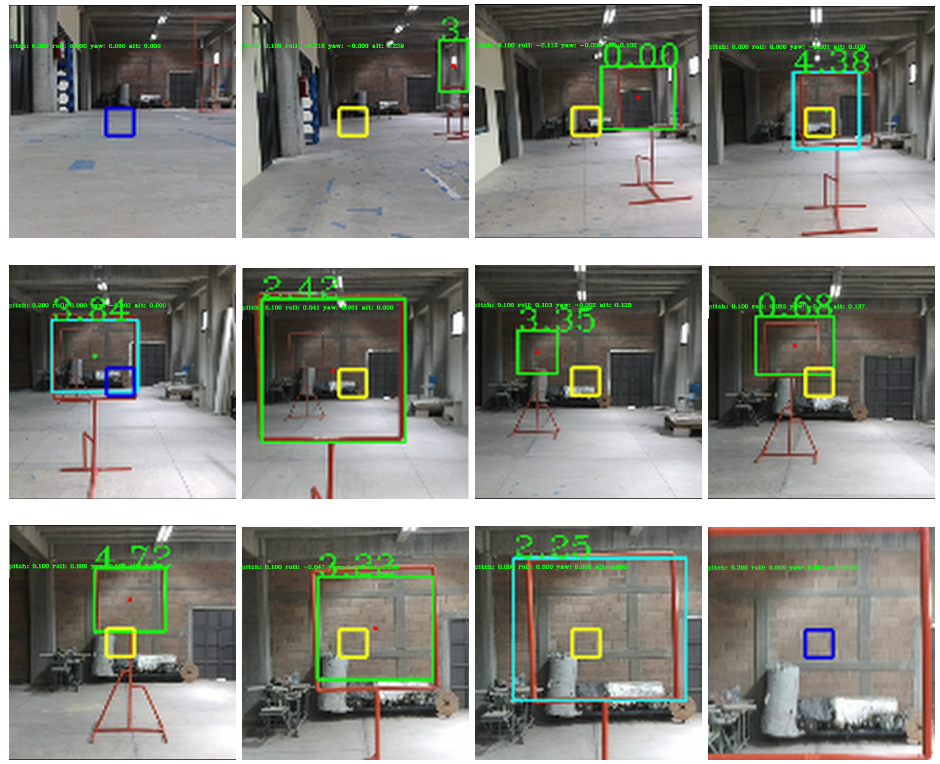
Figure 13. Examples of the GCS while the drone flew autonomously in an indoor environment. Note that the square at the centre of the image turned blue when the drone identified that it was centred with respect to the gate and it was then ready to cross the gate. A video illustrating these experiments can be found at https://youtu.be/P1187astpe0 (accessed on 1 November